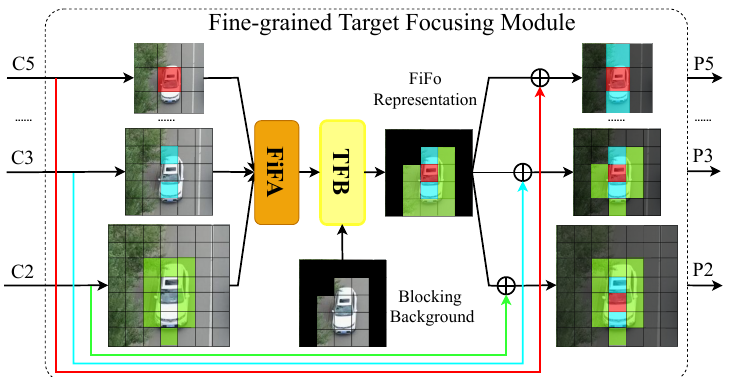
Figure 3. The details of the Fine-grained Target-focusing